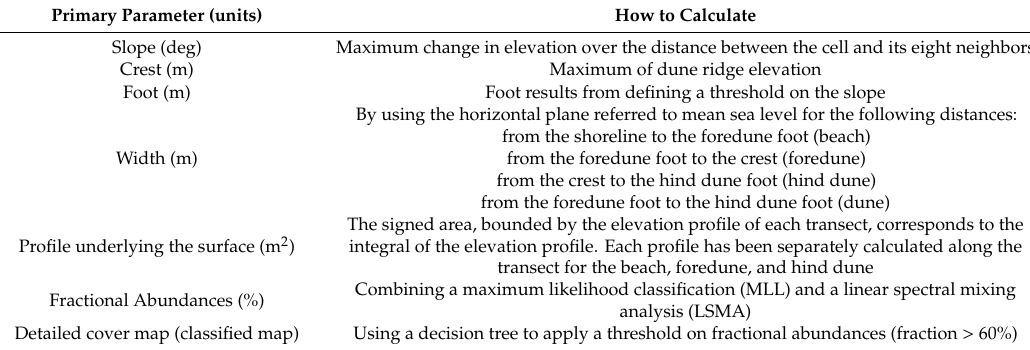
Figure 5. Description of step 1 in Figure 4 : The processing algorithm used is named ‘Field, Figure5. Descriptionof step1 inFigure4: Theprocessingalgorithmusedisnamed‘Field, Hyperspectral Hyperspectral and LiDAR (FHyL) module 3 ′ . and LiDAR (FHyL) module 3 (cid:48) . Table 3. Parameters and products generated for the discrete pixel-based Table 3. Parameters and products generated for the discrete pixel ‐ based analysis.